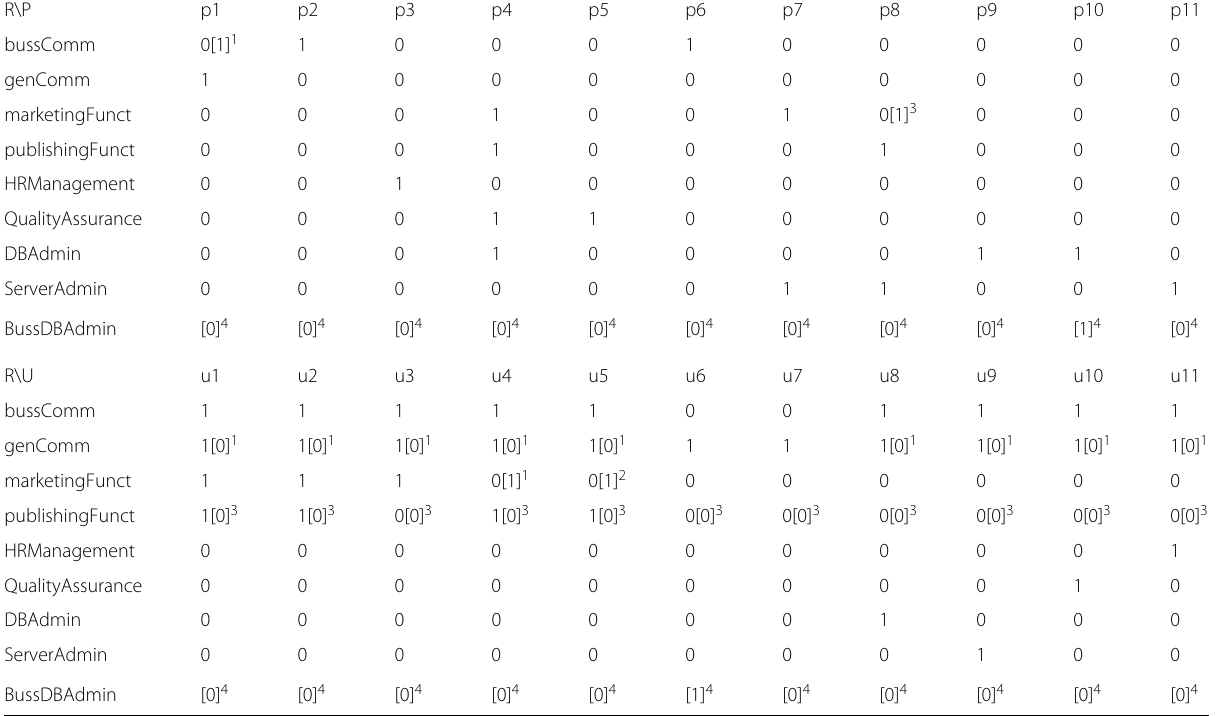
Table 2 Permission-to-Role matrix PA (top) and User-to-Role matrix UA T (bottom)